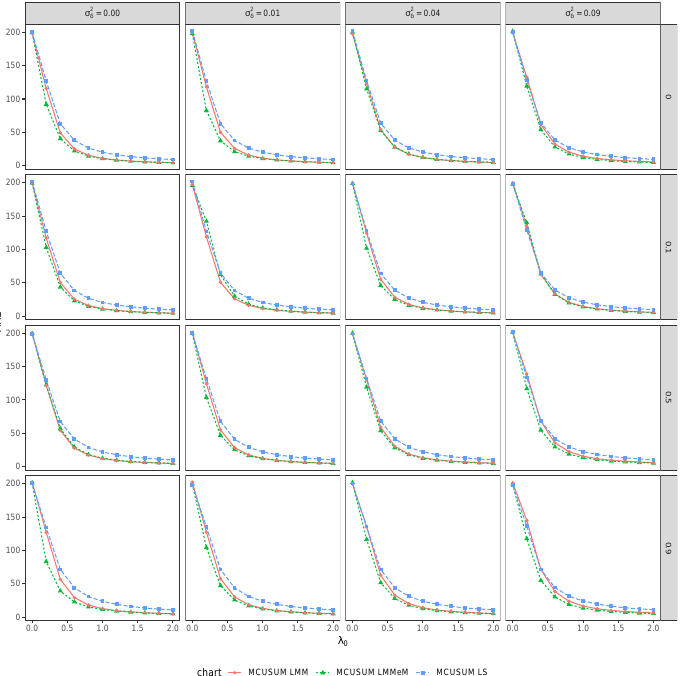
Figure 4. Effect of ignoring measurement errors and/or random effects on ARL performance for MCUSUM control charts under different shifts in intercept.